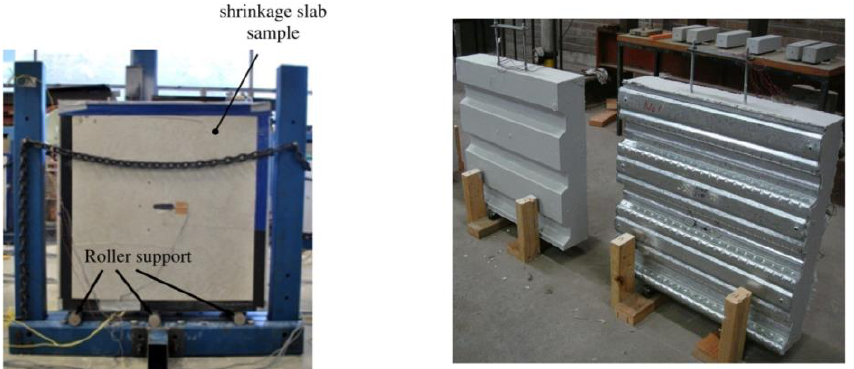
Figure 3. Typical experimental setups for measuring the characterization of the shrinkage-induced deformations [14,17].